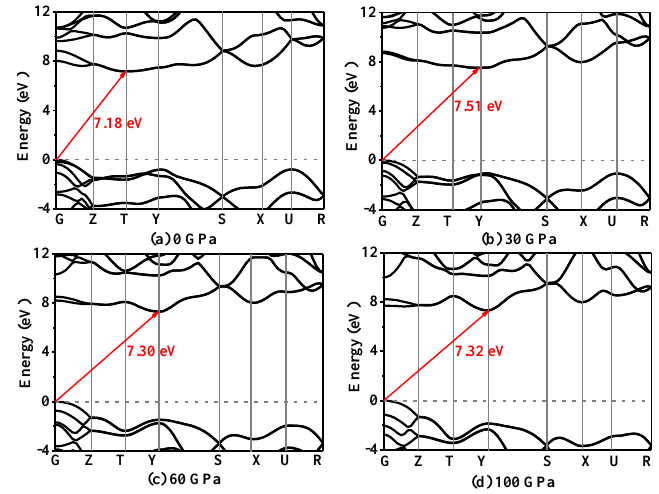
Figure 7. The band structures under pressure of Pnma -BN, ( a ) 0 GPa, ( b ) 30 GPa, ( c ) 60 GPa, ( d ) 100